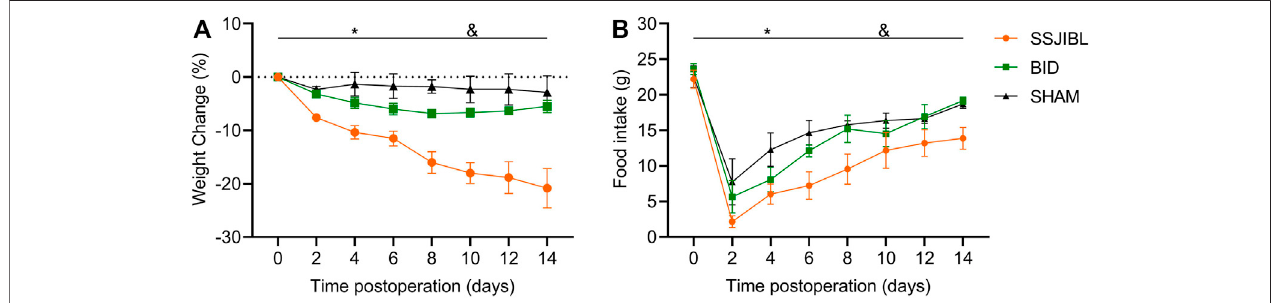
FIGURE 2 | BW (A) and FI (B) of rats after surgery ( n = 6 for SSJIBL, n = 6 for Sham, and n = 6 for BID). Body weight (BW); food intake (FI). * p < 0.05 for SSJIBL versus SHAM group; & p < 0.05 for SSJIBL versus BID.